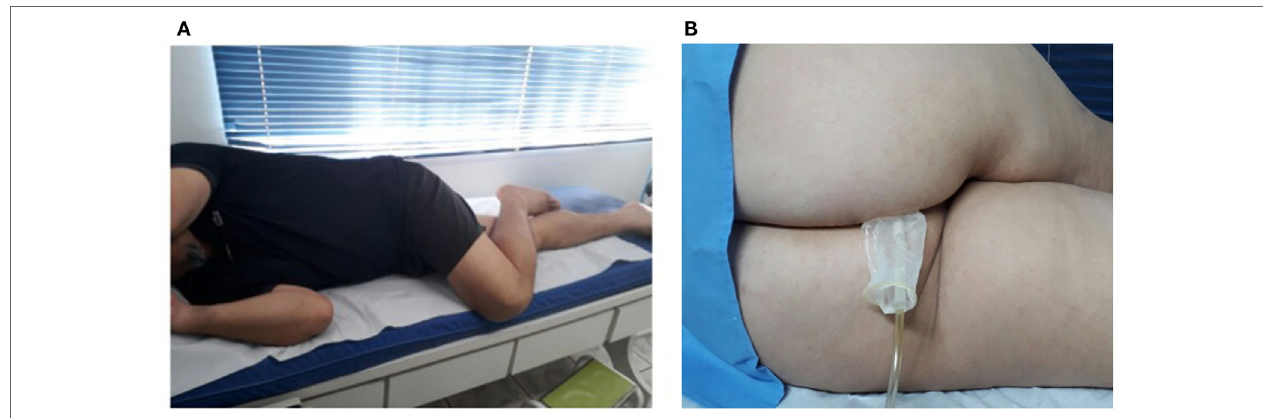
FIgURe 2 | (A) Patient positioning (right lateral decubitus position) for both the taring and biofeedback stages. (B) Probe insertion using the decubitus positioning (here inverted for probe